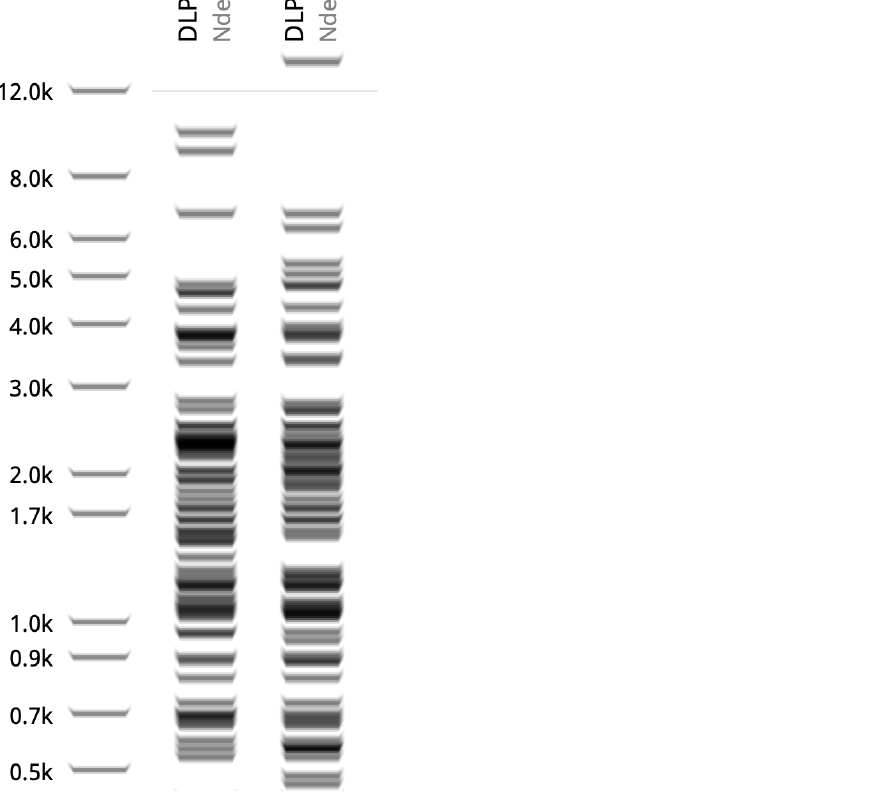
Figure 9. In silico digestion of DLP1, and DLP2 with Nde I using Geneious Prime. Ladder is 1 kb Plus